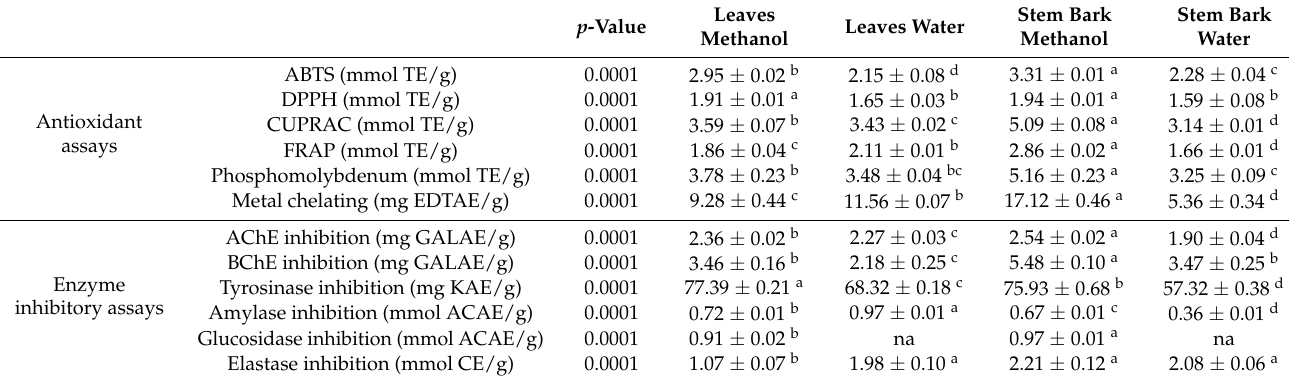
Table 4. Antioxidant and enzyme inhibitory properties of P. kotschyi extracts *.